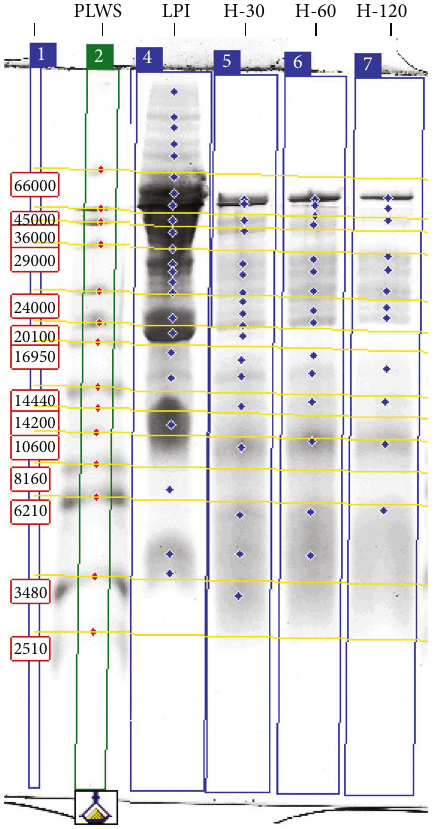
Figure 3: Results of the peptide separation (Schägger and von Jagow [19] method) of lupin protein preparations. Lanes: PLWS: peptide and low-molecular-weight standards; LPI: lupin protein isolate; H-30, H-60, and H-120: LPI hydrolysates. Table 2: Relative content (%) of protein fractions in lupin protein preparations (Schägger and von Jagow [19] procedure).